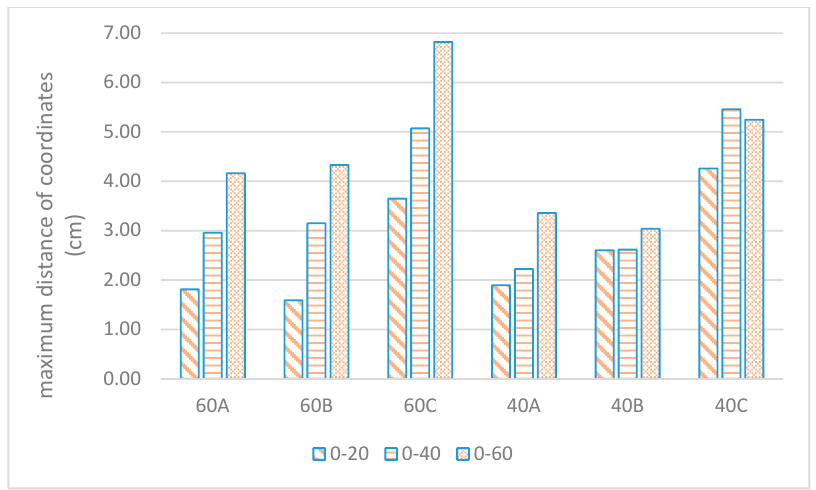
Figure 10. Average maximum AESL along the z -axis.